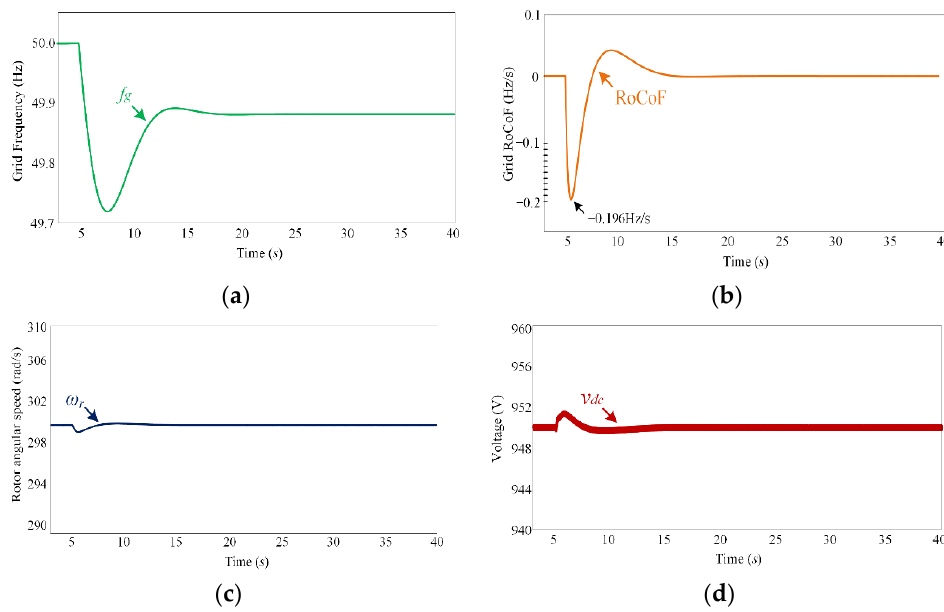
Figure 15. Simulation results when DFIG system provides inertia support and the speed recovery control bandwidth is 1 Hz. ( a ) Grid frequency; ( b ) RoCoF; ( c ) rotor speed; ( d ) DC-link voltage.